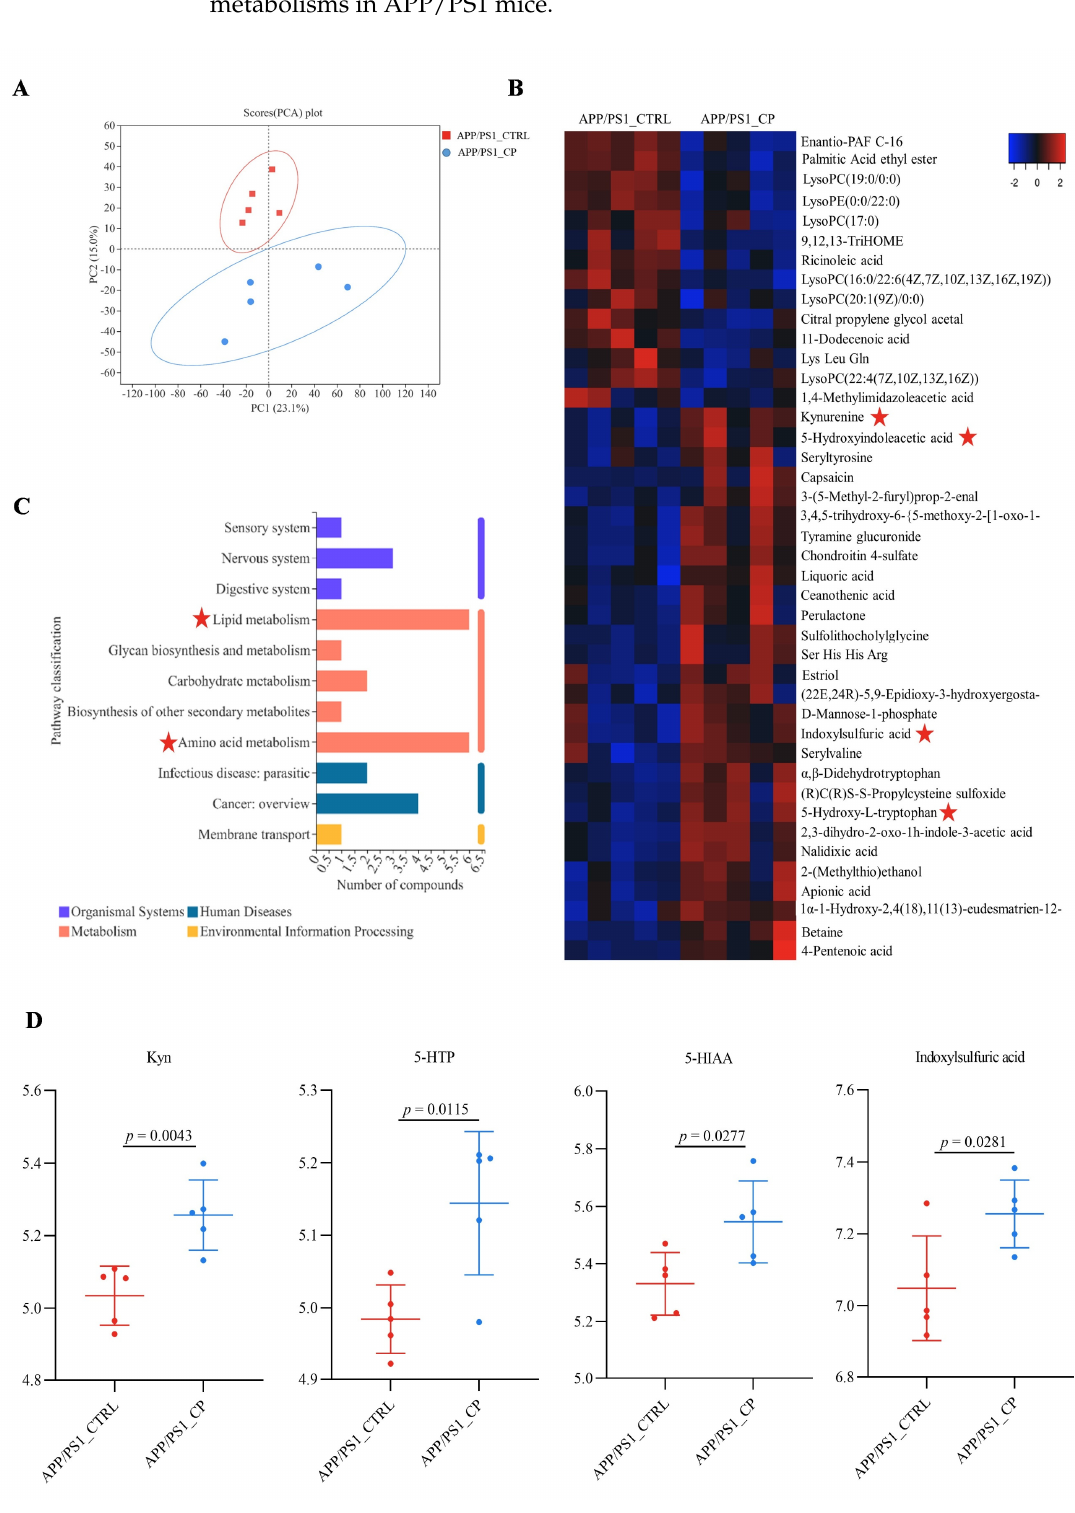
Figure 4. APP/PS1 mice show significant effects in serum metabolites that are normalized by capsaicin (all groups: n = 5). ( A ) Principal component analysis (PCA) was used to measure the metabolite profiles in serum samples. ( B ) Hierarchical clustering analysis of the top 50 significant metabolites